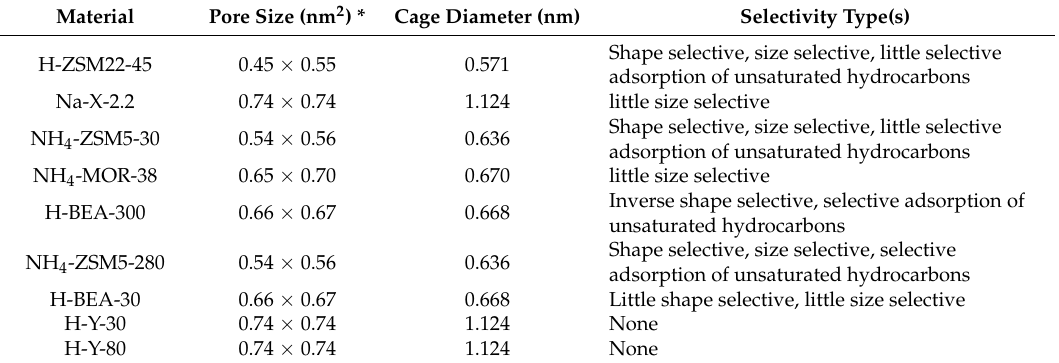
Table 5. The different powdered zeolite samples used, their respective theoretical pore size and cage diameters [22] and the observed selectivity types with regards to the cuticular hydrocarbons. When several zeolites showed the same selectivity type, but the extent was very different, the zeolite(s) with the least selectivity are indicated as “little selective”. H-Y-80 is used as a reference and thus not selective by